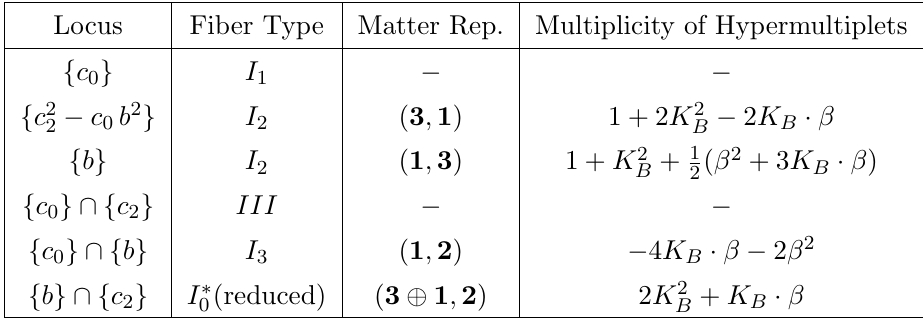
Table 3 . Representations and multiplicities of the matter associated to codimension two singular- ities for the restricted model